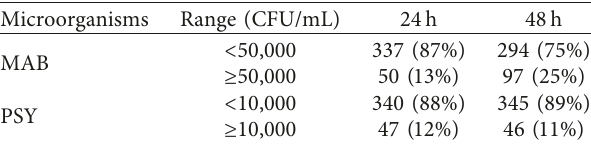
Table 3: Percentage of samples according to the quality standards of the industry and frequency of milk collection (24 and 48h) for